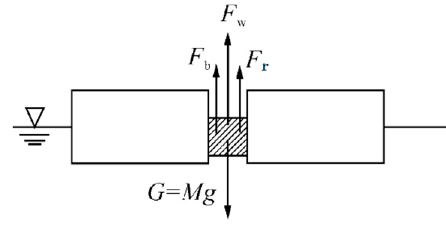
Figure 1. The sketch of the water column in the gap (reproduced from Cong et al. [6]).